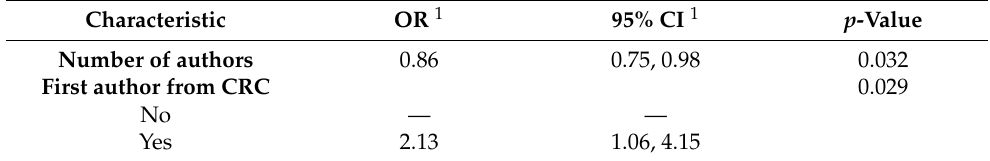
Table 4. Factors associated with publication based on multivariate logistic regression model.